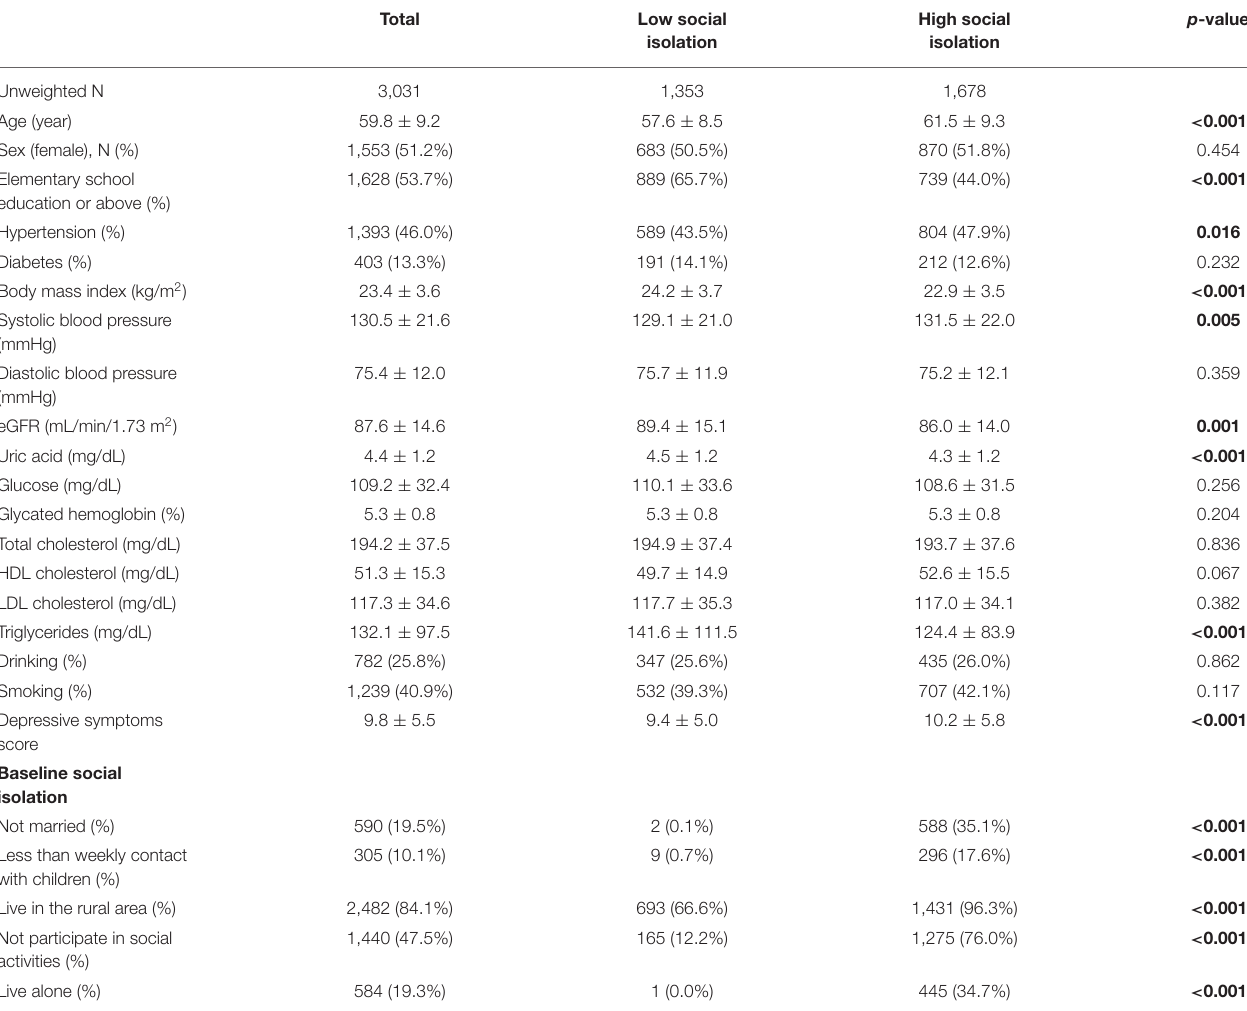
TABLE 1 | Baseline characteristics of participants ( n = 3,031) according to social isolation